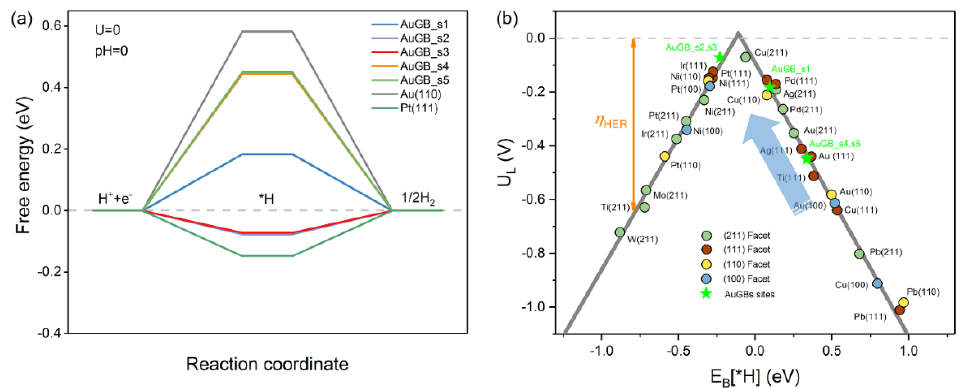
Figure 2. ( a ) The calculated free−energy diagram of HER at the equilibrium potential (U = 0 V) for Au(110) (black), Pt(111) (green) and different active sites on Au GBs. ( b ) The volcano relation of the limiting potential for HER as a function of E B (H*). The arrow indicates the desired direction for catalyst design with higher activity, and the color pentagrams represent GB sites on Au surface for prodigious promotion of HER. Theoretical overpotentials ( η HER ) are the vertical difference between the points and the equilibrium potential (red dashed line).